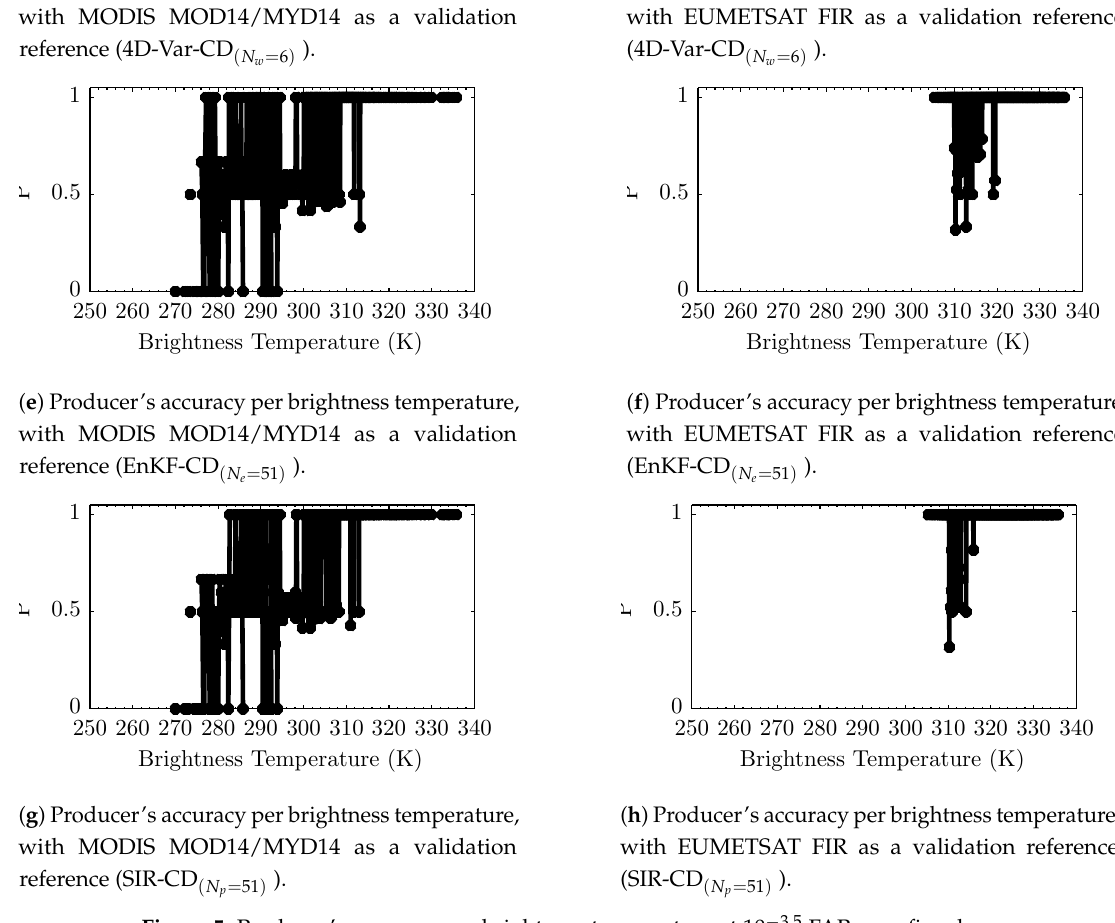
Figure 5. Producer’s accuracy per brightness temperature at 10 − 3.5 FAR over five